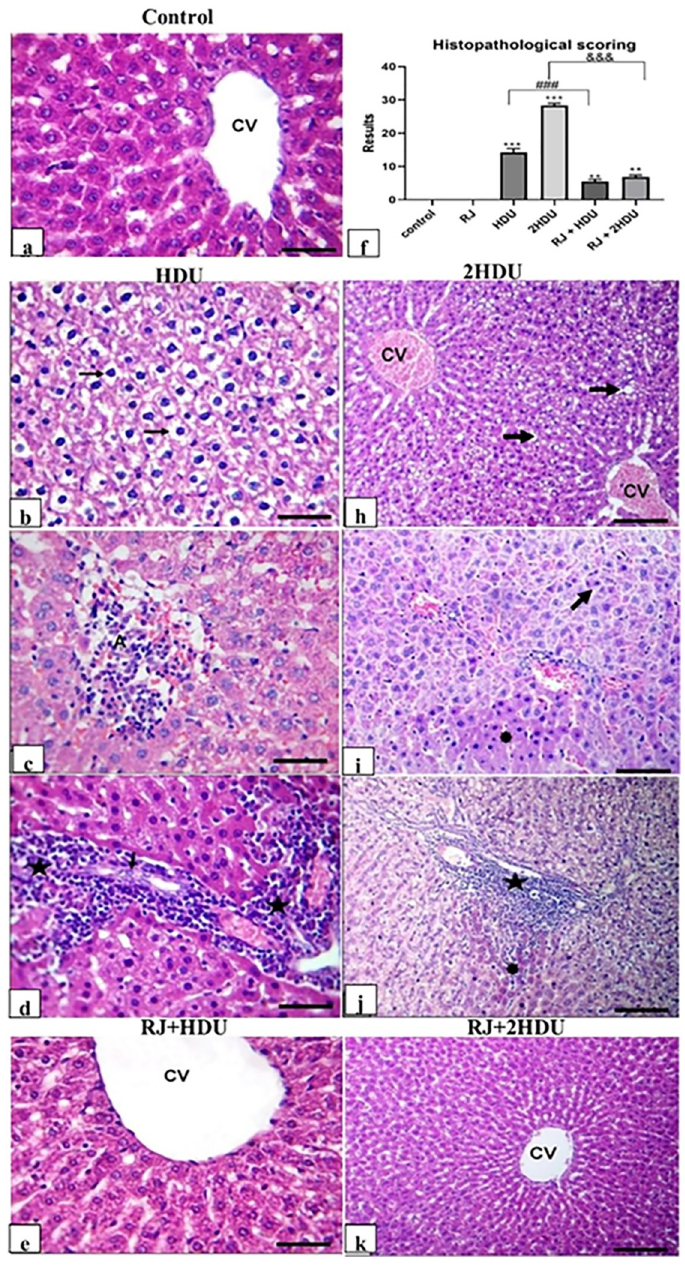
Fig 8. Photomicrograph of rat liver section stained with HE (scale bar = 50 μ m): (a) control rats showing normal hepatic histology and architecture. (b, c, d) severe hydropic degeneration of hepatocytes (long black arrow), hepatic necrosis (A), and intense inflammatory cell infiltration in the portal area (black star) with biliary cell degeneration (short black arrow) of rats that received 225 mg /kg bwt HDU daily. h, i, j) severe hydropic degeneration of hepatocytes (long black arrow), apoptotic bodies (short black arrows), congestion of central vein (CV), sharp outline vacuoles (long black arrows), coagulative hepatocellular necrosis (asterisks), intense inflammatory cell infiltration in hepatic necrosis (long black arrows) and in the portal area (black star) in rats that received 450 mg /kg bwt HDU daily In addition, (e) normal hepatic histology and architecture in rats that received a daily dose of 225 mg /kg bwt HDU + 100 mg RJ. (k) multifocal hepatocytes with mild cytoplasmic vacuolation and mild sinusoidal dilatation in rats received a daily dose of 450 mg /kg bwt HDU + 100 mg RJ. (f) Quantitative histopathological scoring.